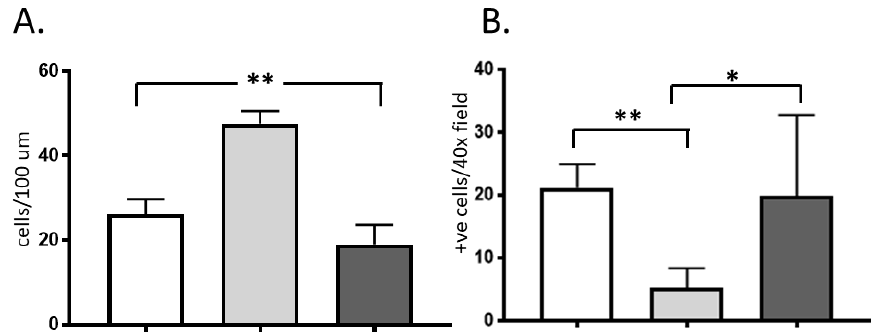
Figure 2. Enterocyte ( A ) and polymorphonuclear (PMN) leukocyte ( B ) counts in rat, (white bar) pig (light grey), and human (dark grey) intestines ( n = 7). Enterocytes were counted using 4 (cid:48) ,6-diamidino-2-phenylindole (DAPI) staining on the sides of longitudinally oriented villi on several 100 µ m segments; PMNs were counted in villi on ten random fields at high magnification ( × 400) (data shown as mean ± SD). * p < 0.05, ** p <